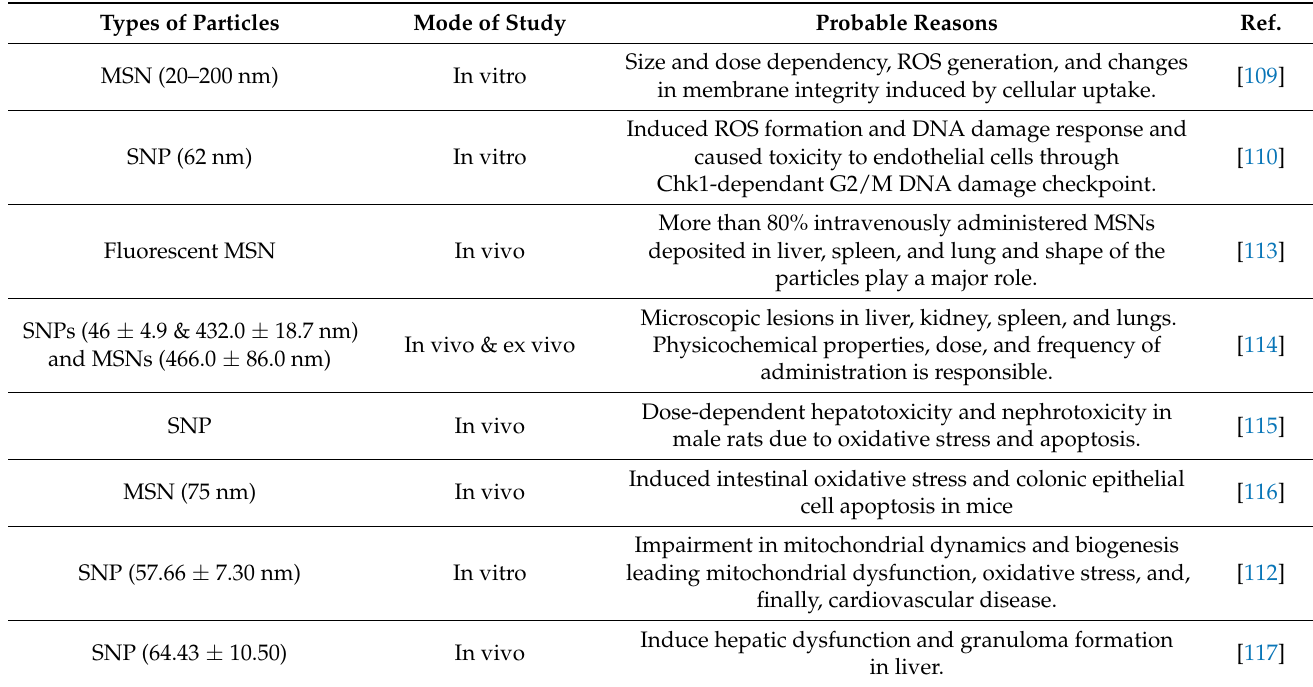
Table 4. Observed toxicological effects of